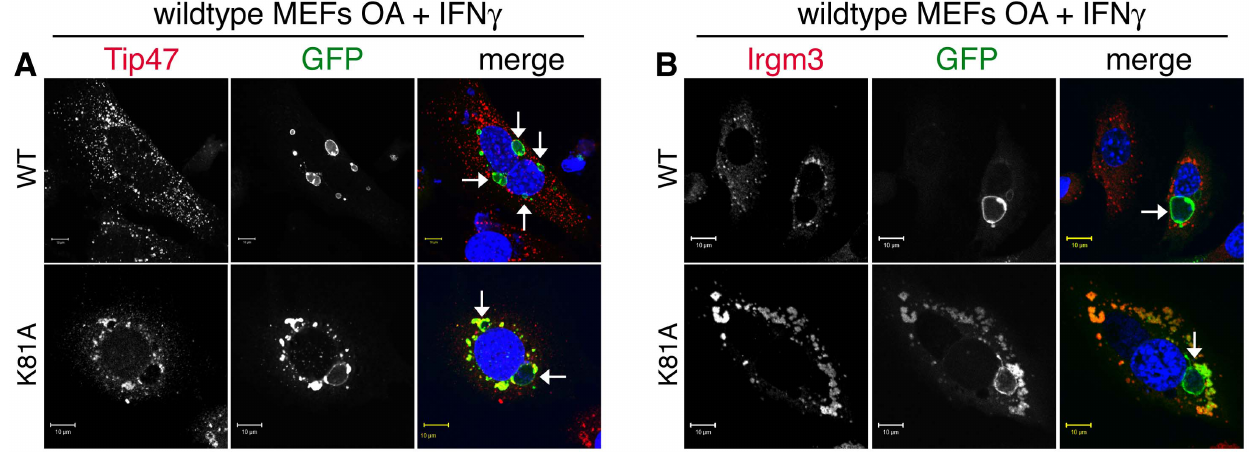
Figure 6. A GTP-locked Irgb10 mutant targets Irgm3-positive LDs in wildtype MEFs. Wildtype MEFs were transfected with GFP-tagged versions of Irgb10 WT and Irgb10 K81A . Cells were treated overnight with OA, infected with C. trachomatis and treated with IFN c at 3 hpi. At 20 hpi cells were stained for ( A ) the LD marker Tip47 and DNA or ( B ) Irgm3 and DNA. Representative images are shown. Arrows point at Hoechst-stained inclusions.